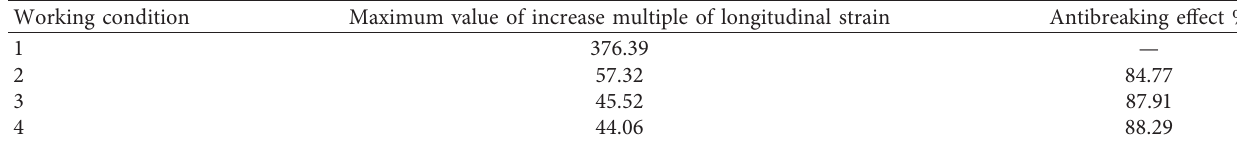
Figure 9: Increase multiple of longitudinal strain. (a) Working condition 1 ∼ 4. (b) Working condition 2 ∼ 4. Table 9: Antibreaking effect of longitudinal